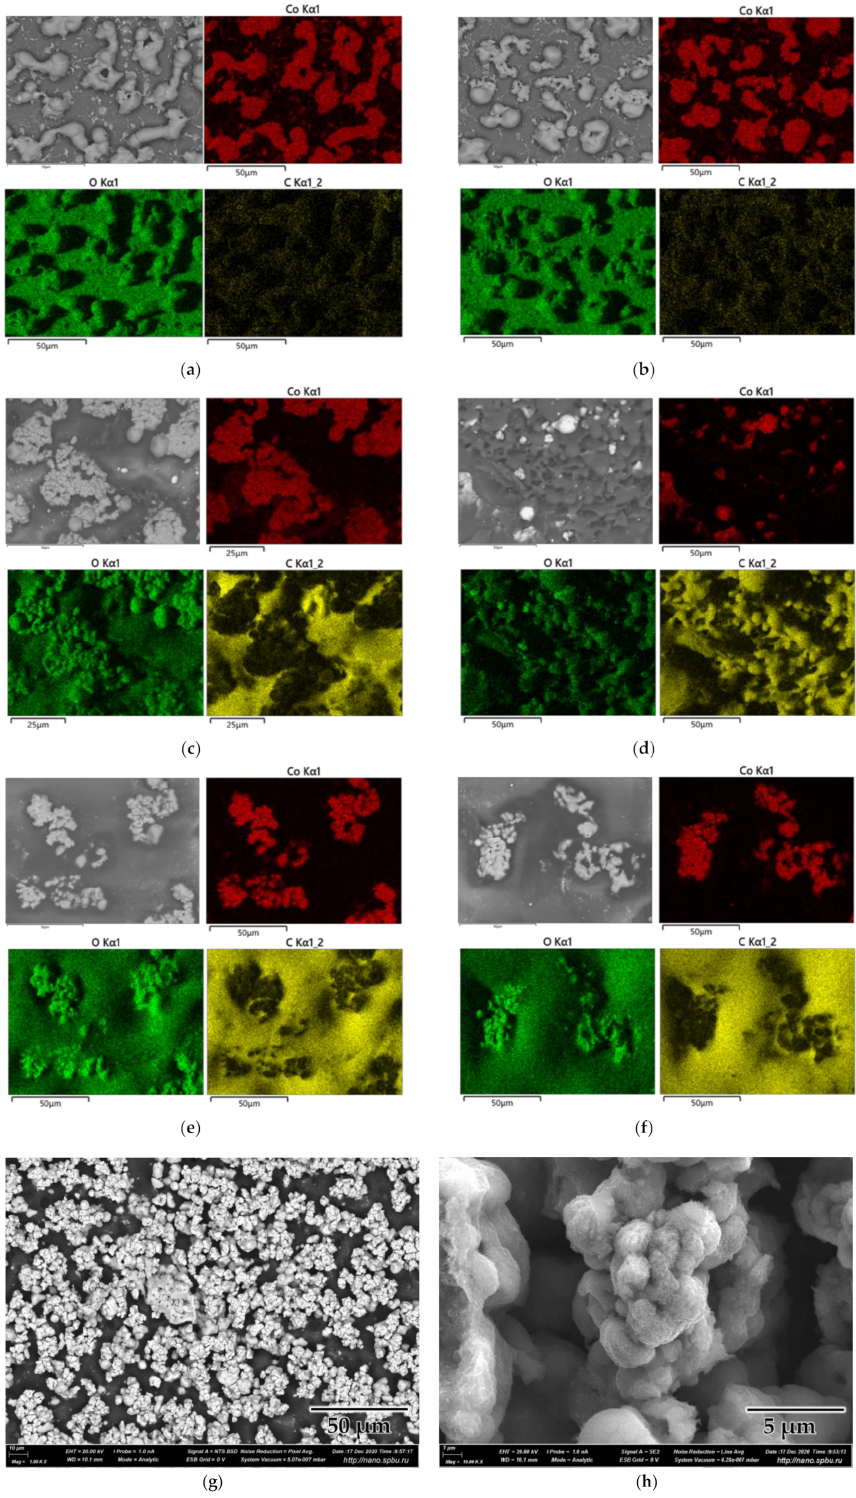
Figure 7. SEM images and EDS mappings of the patterns fabricated on glass, PEN, and PET substrates using a scanning speed of 5 mm/s, and a laser pulse energy of ( a ) 0.55 nJ and ( b ) 0.74 nJ on glass substrates, ( c ) 0.29 nJ and ( d ) 0.46 nJ on PEN substrates, and ( e ) 0.29 nJ and ( f ) 0.46 nJ on PET substrates. ( g ) FE-SEM image of the patterns fabricated on PEN substrates using a scanning speed of 5 mm/s and a laser pulse energy of 0.29 nJ, and ( h ) an enlarged image of ( g